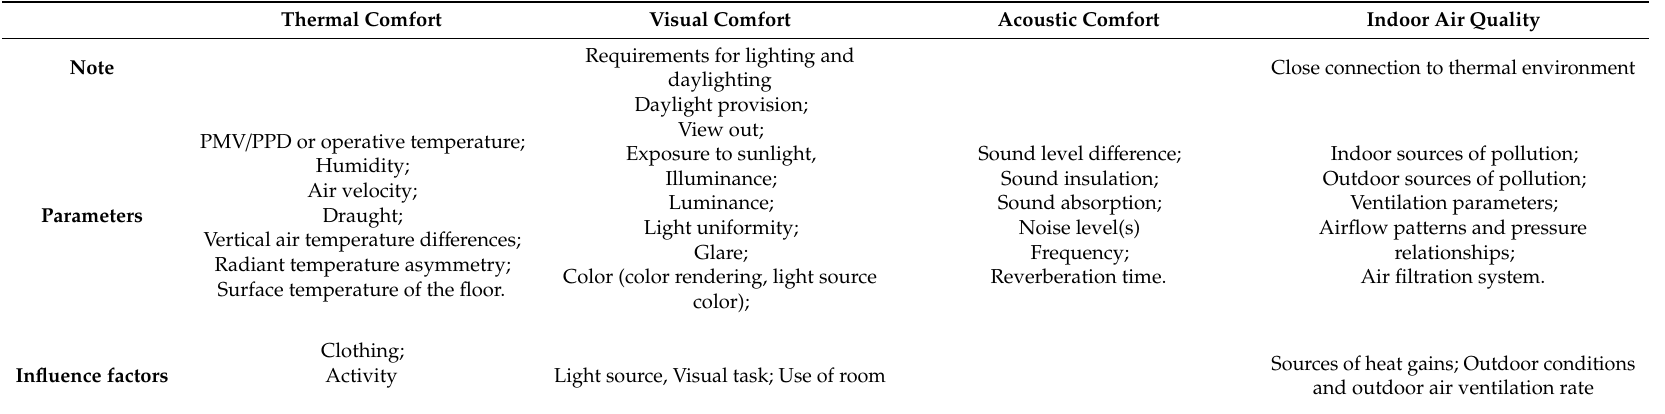
Table 1. Indoor environment quality factors and their